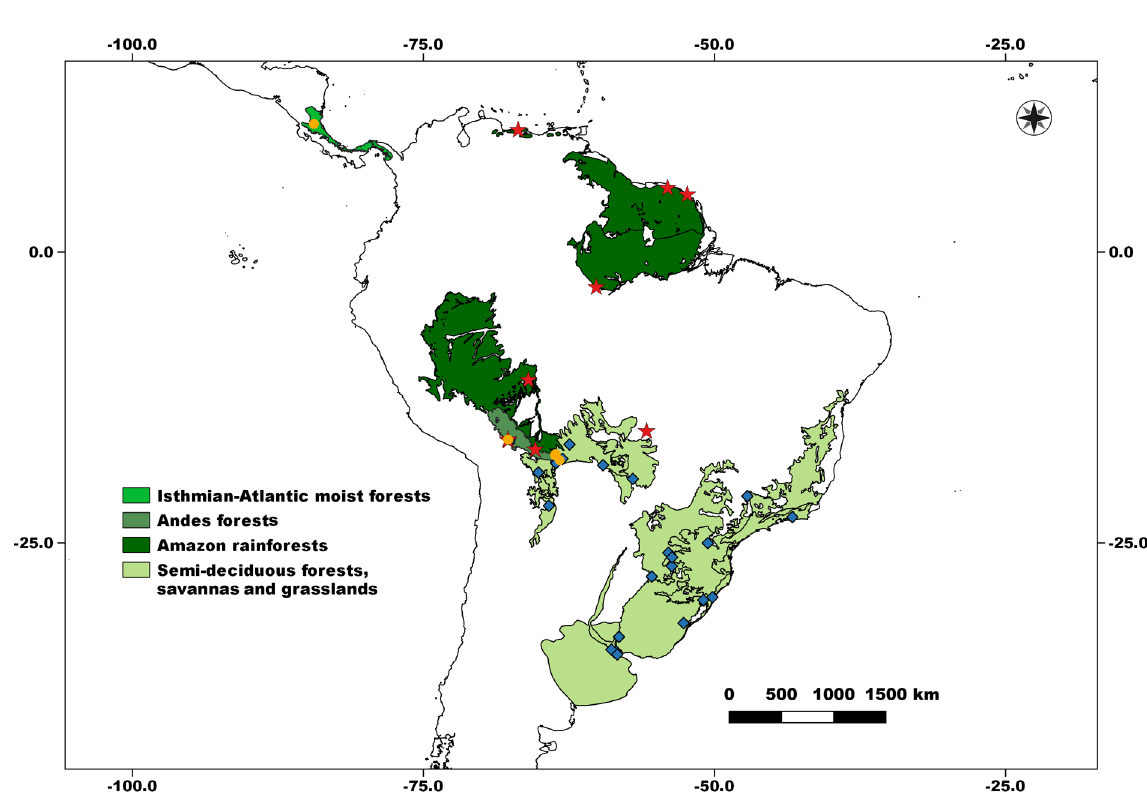
Fig. 7. Ecoregion distribution of Synemosyna spp. Orange circle = S. nicaraguaensis Cutler, 1993; red star = S. myrmeciaeformis (Taczanowski, 1871); blue diamond = S. aurantiaca (Mello-Leitão,